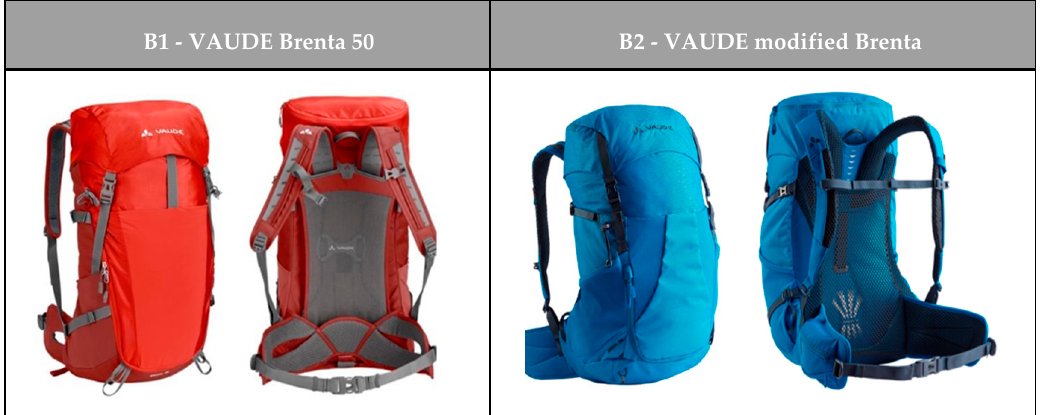
Figure 1. Backpack models. ( Left ): VAUDE Brenta 50. ( Right ): further developed Brenta model. The volumetric capacity of the backpacks (B1 and B2) is 50 L with dimensions of 61 × 33 × 29 cm. The backpacks were loaded with an additional weight (4.1 kg) using PET water bottles together with balloons as filling material (total weight: 5.4 kg). Care was taken to distribute the weight evenly and realistically. Together with the participant the loaded backpack was adjusted and adapted likewise to ensure an optimal and reproducible